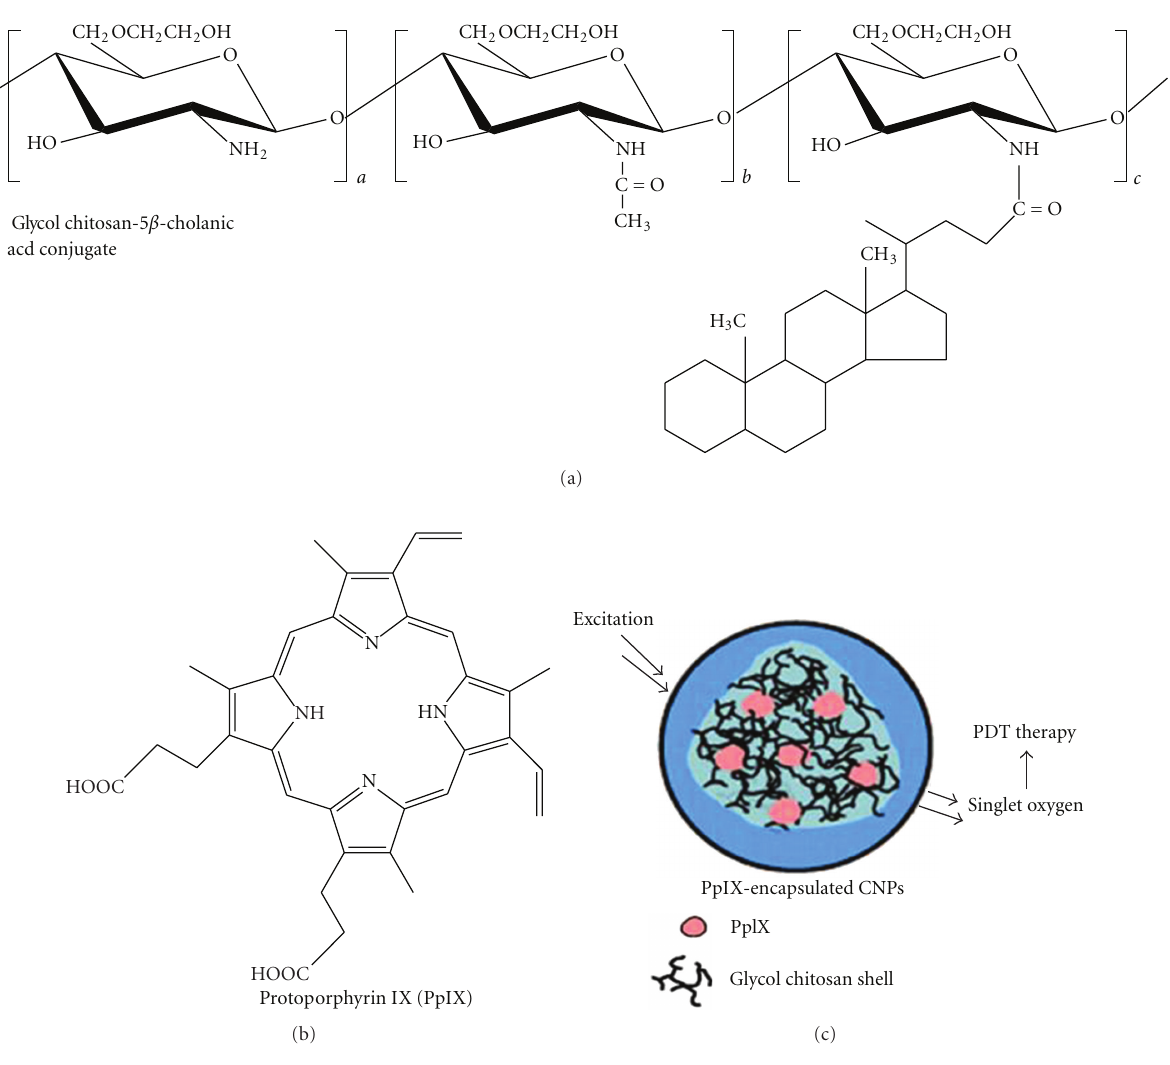
Figure 9: Chemical structure of glycol chitosan-5 β -cholanic acid conjugate and schematic representation of photosensitizer-encapsulated chitosan-based nanoparticles for PDT